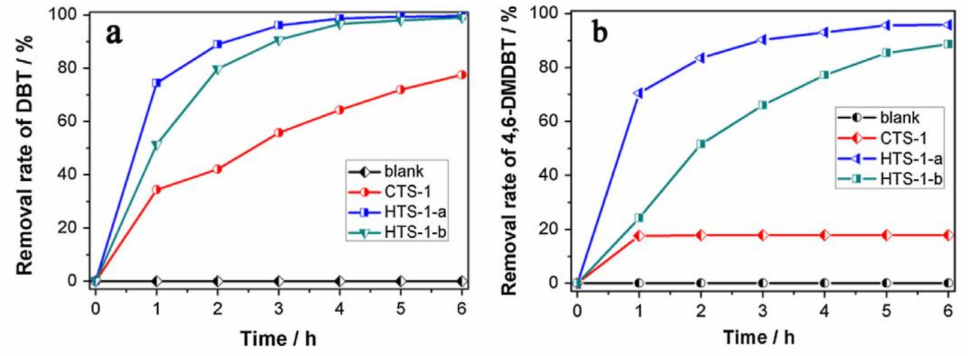
Figure 5. Oxidation of DBT ( a ) and 4,6-DMDBT ( b ) over conventional TS-1 (CTS-1) and mesoporous TS-1 (HTS-1-a and HTS-1-b). Reprinted with permission from ref. [82]. Copyright 2017